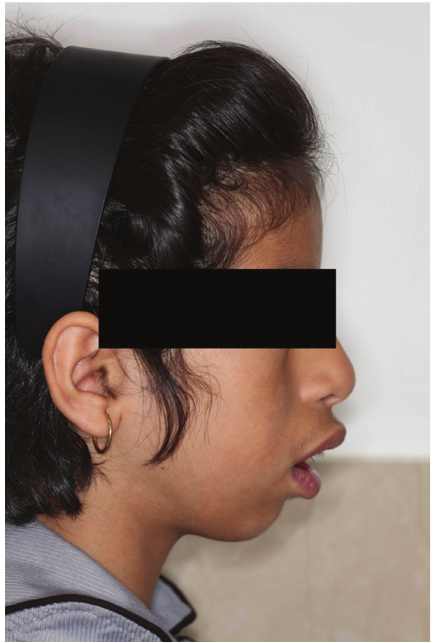
Figure 3: Profile view of the patient showing lip incompetency at rest.